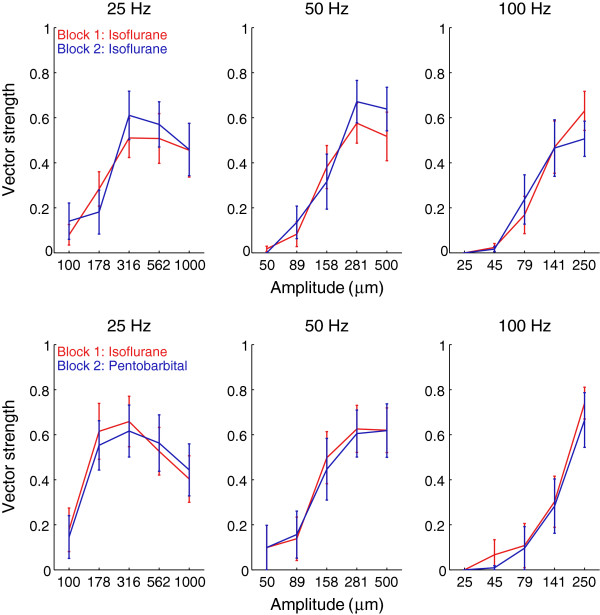
Effect of anesthesia on the temporal structure of the response over the population. Top: Entrainment in the control condition. Each point indicates the mean vector strength across single units of the same block under the same condition of stimulus. Error bars denote the standard error of the mean. While the degree of entrainment is highly variable across afferents (as indicated by the large error bars), it is consistent across blocks. Bottom: Entrainment in the experimental group.